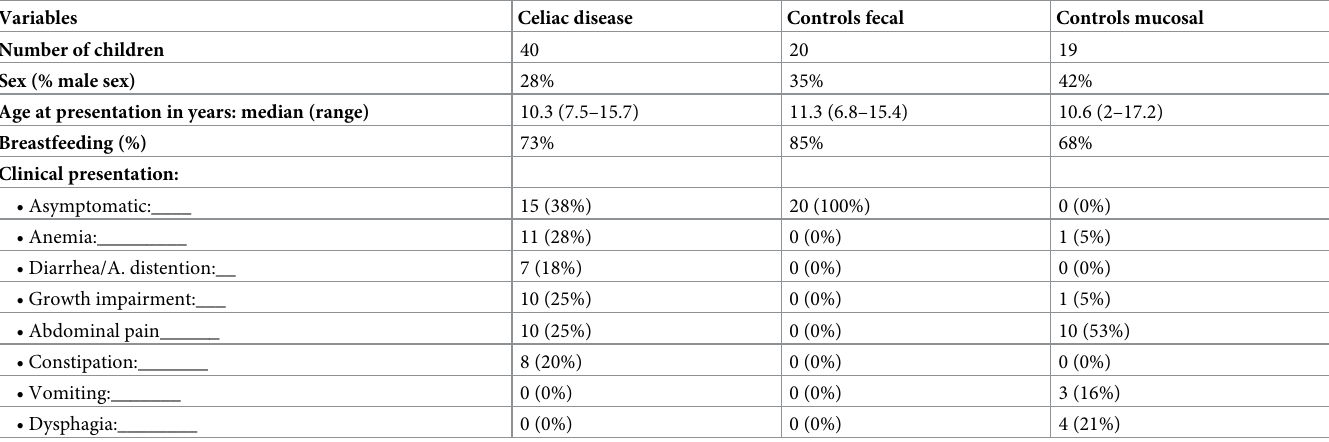
Table 1. Patients demographic and clinical